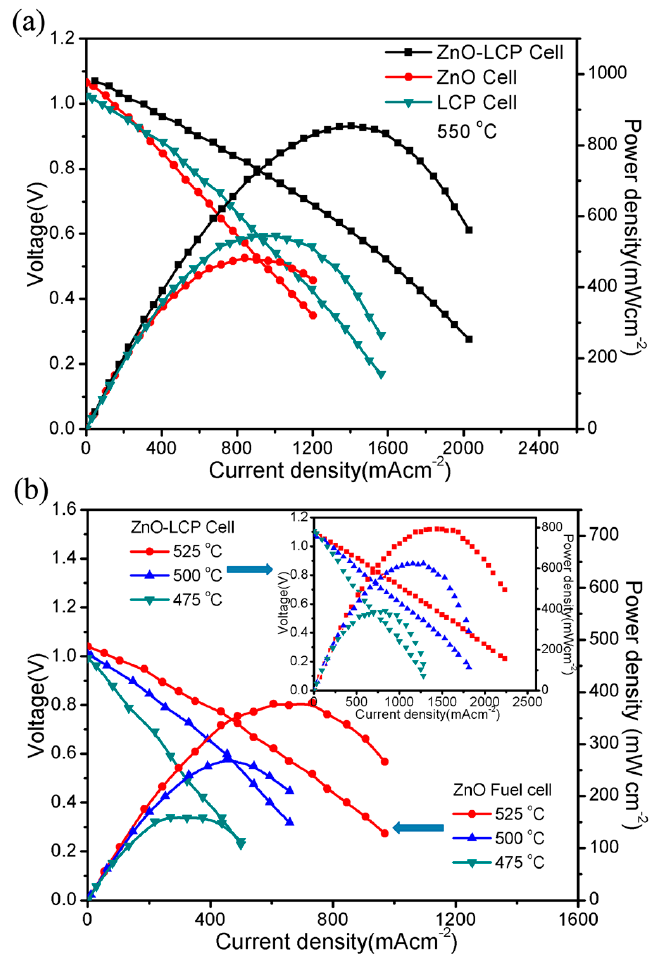
Figure 4. ( a ) Electrochemical performance for fuel cells based on ZnO, LCP and ZnO-LCP at 550 °C for comparison ( b ) Low-temperature performance of fuel cells with ZnO and ZnO-LCP at various temperatures.